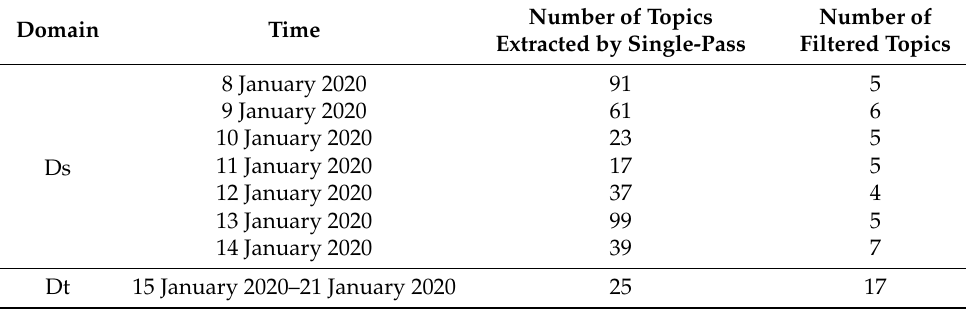
Table 6. The number of topics extracted by single-pass in T2 and T3. Domain